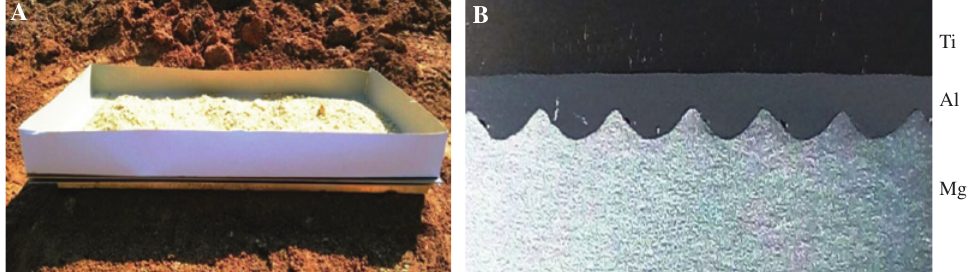
Figure 1: The scene drawing and macrofigure of three-layer plates in the experiment. (A) The scene drawing of three-layer plates. (B) The macrofigure of three-layer plates.